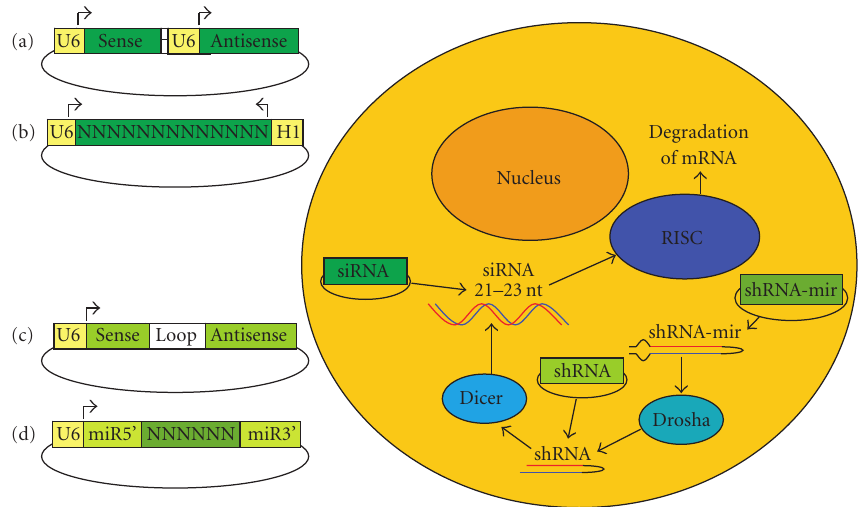
Figure 2: Intracellular siRNA molecule generation via plasmids. Dual promoter systems can direct the production of siRNA sense and antisense strands which anneal and load into RISC. (a) Tandem sense and antisense strands are driven by individual U6 promoters. (b) A single template transcribes for both the sense and antisense strand via opposing promoter design. (c) The addition of a loop structure between the sense and antisense template driven by U6 promoter generates shRNA molecules. The shRNA is cleaved by Dicer producing the functional siRNA molecule. (d) Second-generation shRNA-mir construct is based on miR-30 primary transcript driven by a single U6 promoter. The shRNA-mir molecule is first cleaved by Drosha creating an shRNA molecule recognized by Dicer thereby entering the RNAi